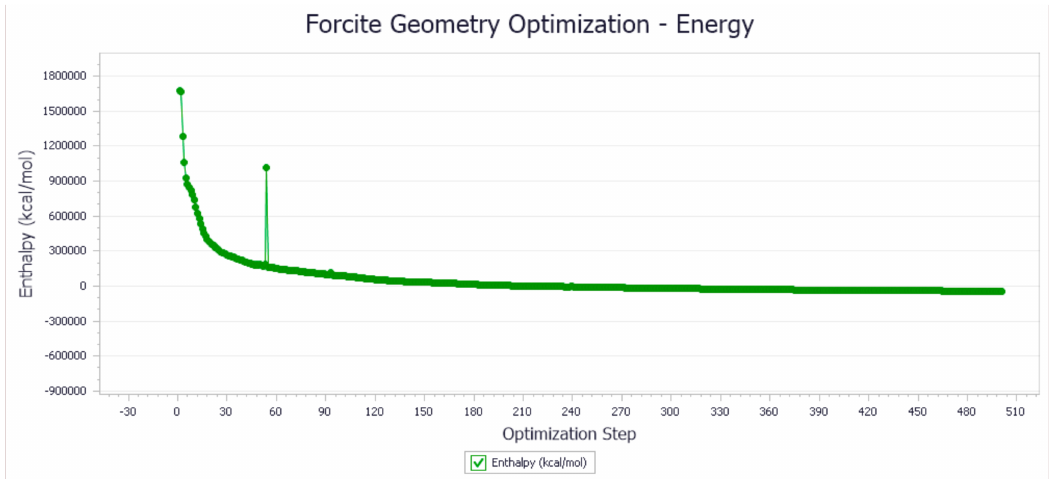
Figure 18. Demulsifier 14 # oil–water interface geometry optimization energy